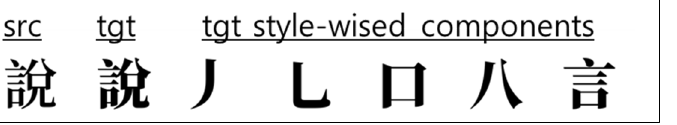
Figure 9. An example of input images. Src and tgt represents source and target images, respectively.